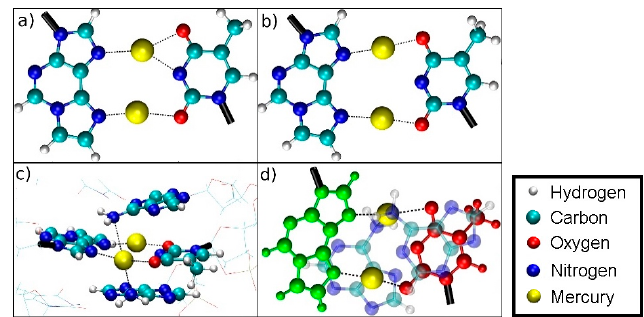
Molecules 2020 , 25 , x 13 of 21 Figure 13. Oscillating bonding patterns of the metal-mediated base pair during the QM/MM MD of